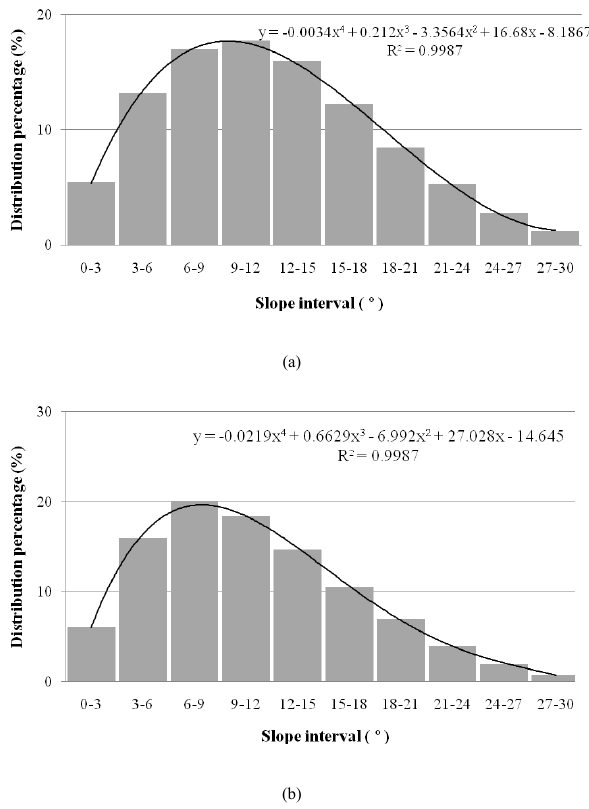
Fig. 8. Slope spectrum and its quantitative analysis for the loess ridge. Panel (a) oblique ridge; Figure 8. Slope spectrum and its quantitative analysis for the loess Panel (b) knoll ridge. ridge. (a) Oblique ridge and (b) knoll ridge.